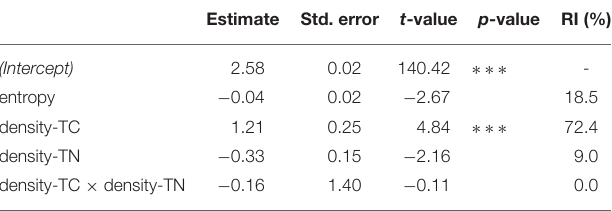
TABLE 6 | Linear regression output for the best predictor combination for verbs in the N-V-A condition: entropy + (density-TC × density-TN). Estimate Std. error t -value p -value RI